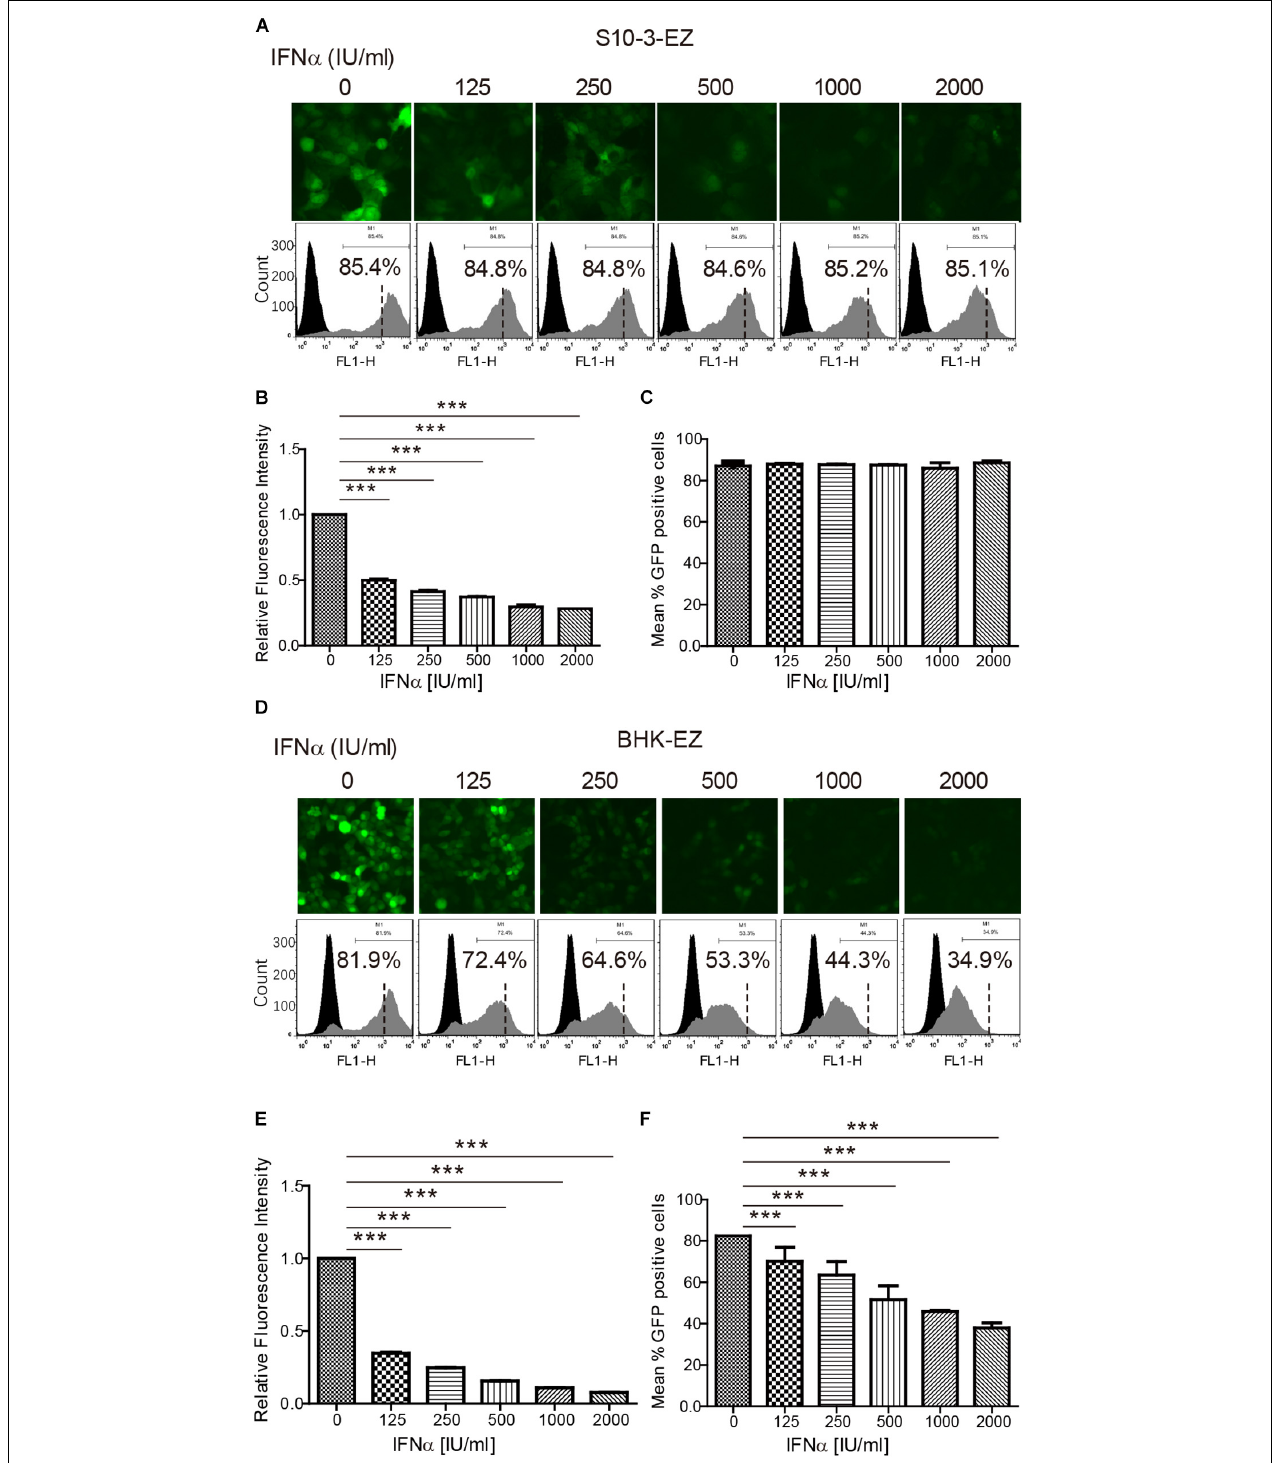
FIGURE 4 | The persistent HEV replicon cell lines are invaluable in assessing HEV antiviral response. The persistent HEV replicon cell lines S10-3-EZ and BHK-EZ were treated with various concentrations (0–2,000 IU/ml) of peg-IFN α -2a for 48 h. (A,D) Observations with fluorescent microscope indicate a dose-dependent inhibition of GFP expression. (B,E) Quantitative FACS analysis confirming peg-IFN α -2a inhibition of GFP expression based on relative fluorescence intensity (RFI). (C,F) The number of GFP-positive cells was determined by FACS after peg-IFN α -2a treatment, shown as a percentage of total counted cells. Error bars indicate standard deviation; * P < 0.05; ** P < 0.01; and *** P <